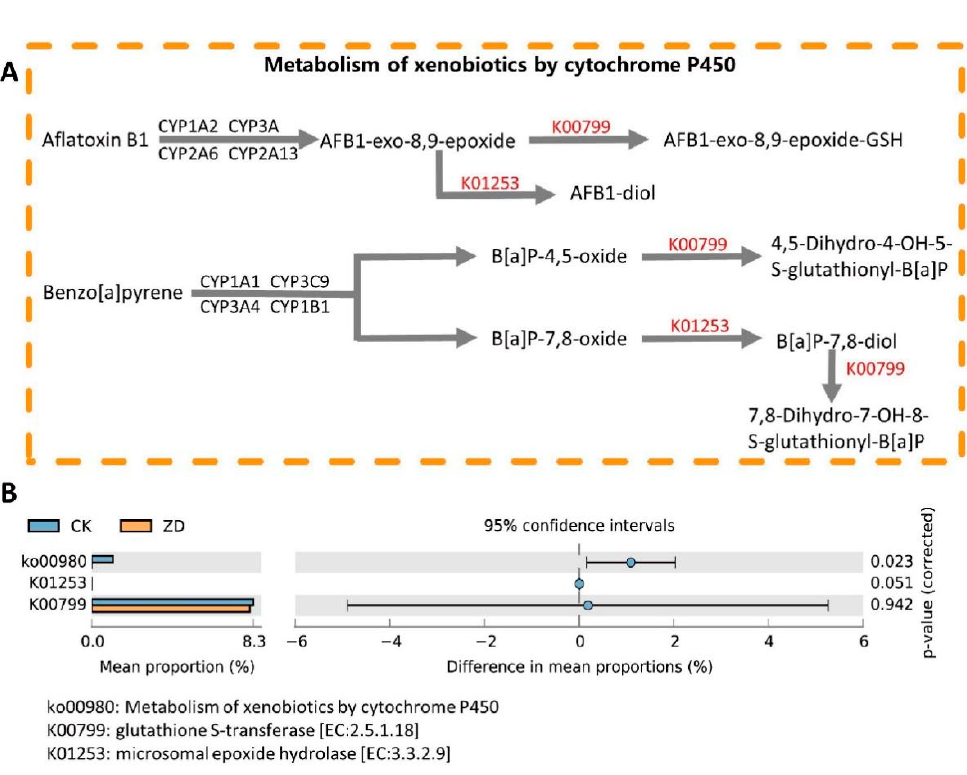
Figure 4. Zinc deficiency promotes distinct functional shifts of gut microbiota. ( A ) Illustration of metabolism of xenobiotics by cytochrome P450 and the related KOs. ( B ) Changes of pathway and KOs in CK and ZD groups. All numbers of KOs and pathway were obtained from KEGG database.